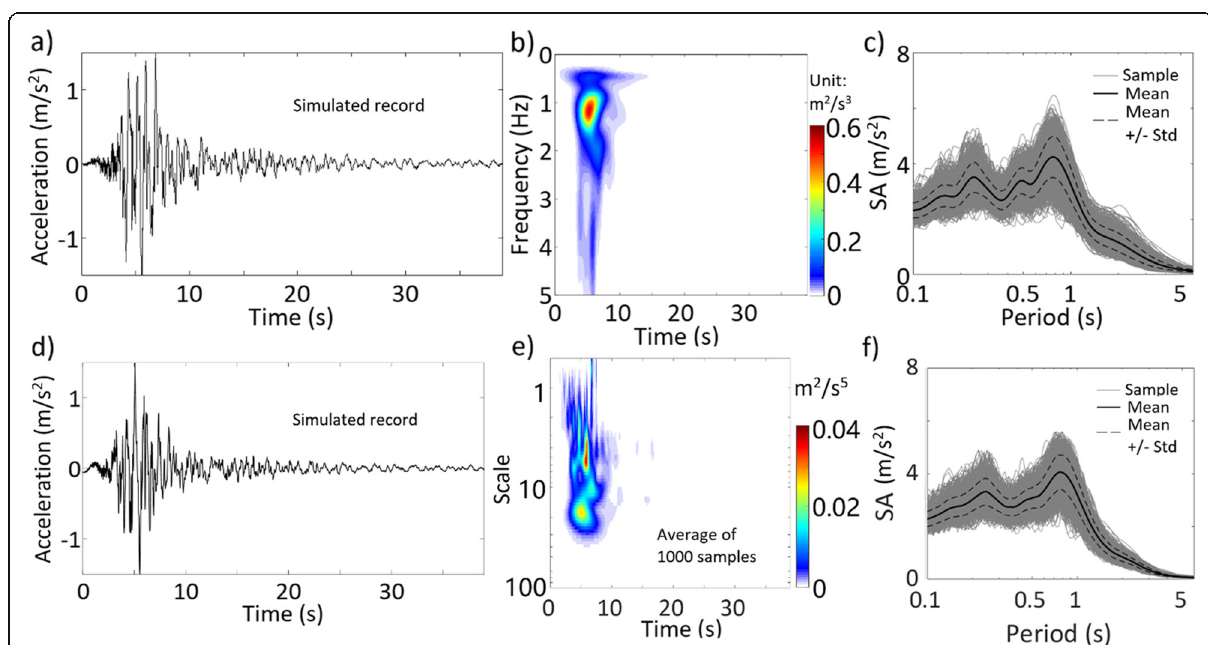
Fig. 11 Results based on simulated nonstationary non-Gaussian records by using ST and WT (the results presented in a to c are for ST, and the results presented in d to f are for WT): a a sampled record based on ST, b average TFPSD of the 1000 sampled record, c SA from 1000 sampled